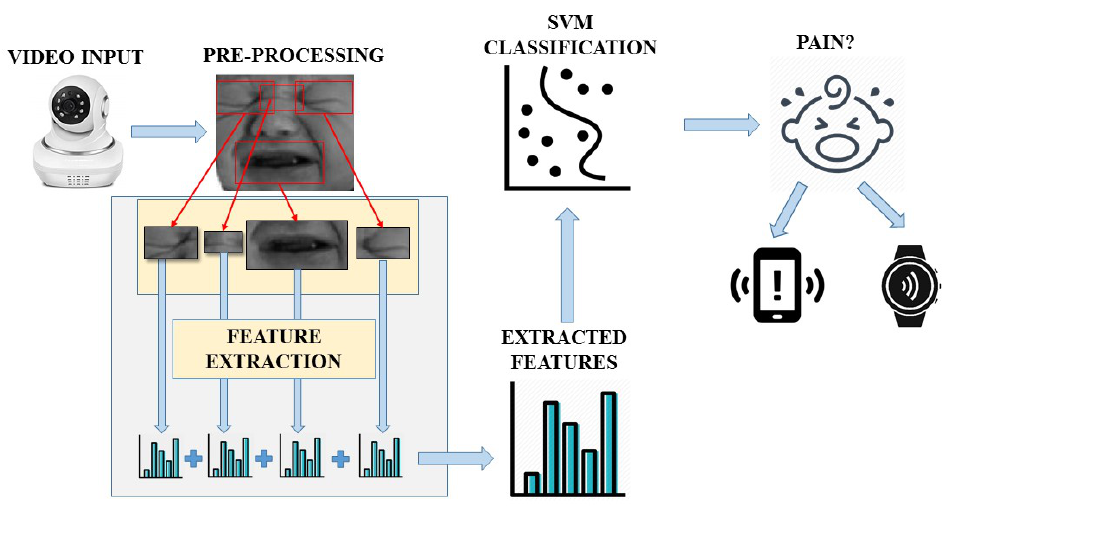
Figure 6. Flowchart of the different